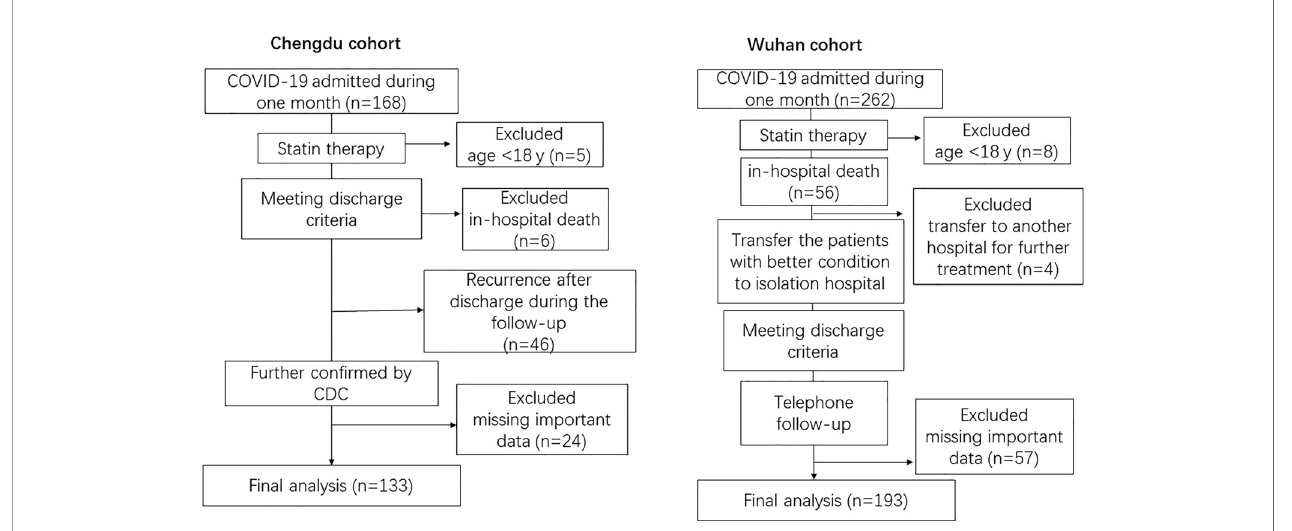
FIGURE 1 | Study fl ow diagram. Centers for Disease Control